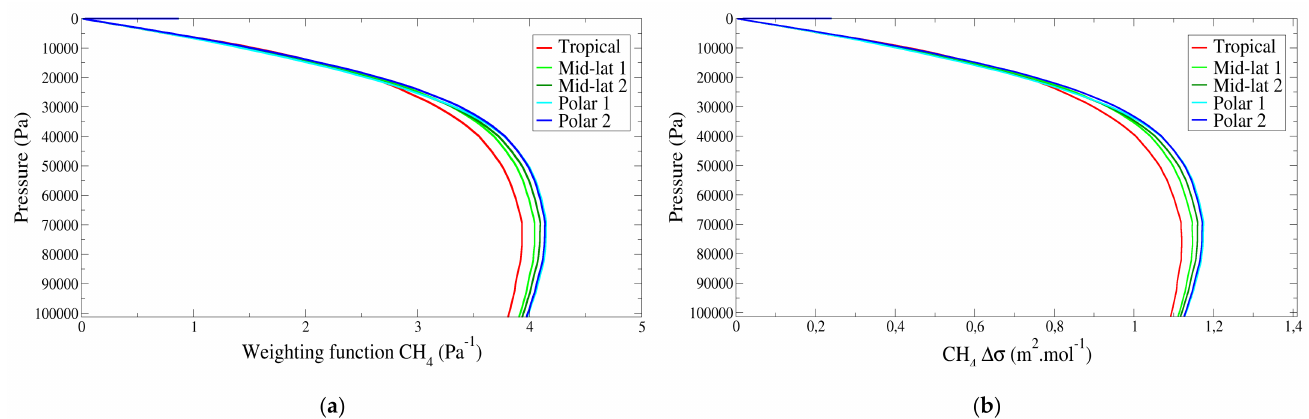
Figure 19. For 5 typical TIGR atmospheres. ( a ) The weighting functions. ( b ) The differences in methane absorption cross sections between λ On and λ Off